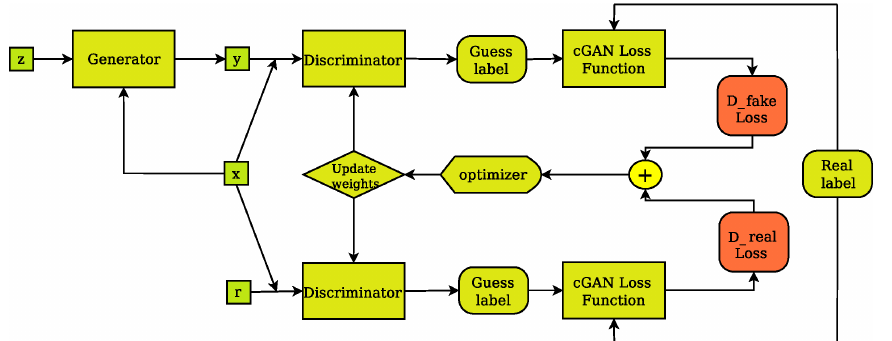
Figure 4. The cGAN discriminator’s training layout. The discriminator compares the input(x)/ground truth(r) pair of images and the input(x)/output(y) pair of images and outputs its guess about how realistic they look. The weights vector of the discriminator is then updated based on the classification error of the input/output pair (D fake Loss) and the input/target pair (D real